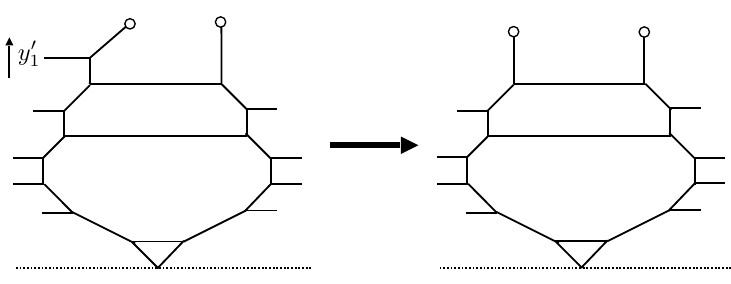
Figure 15 . A decoupling limit from 9 flavors to 8